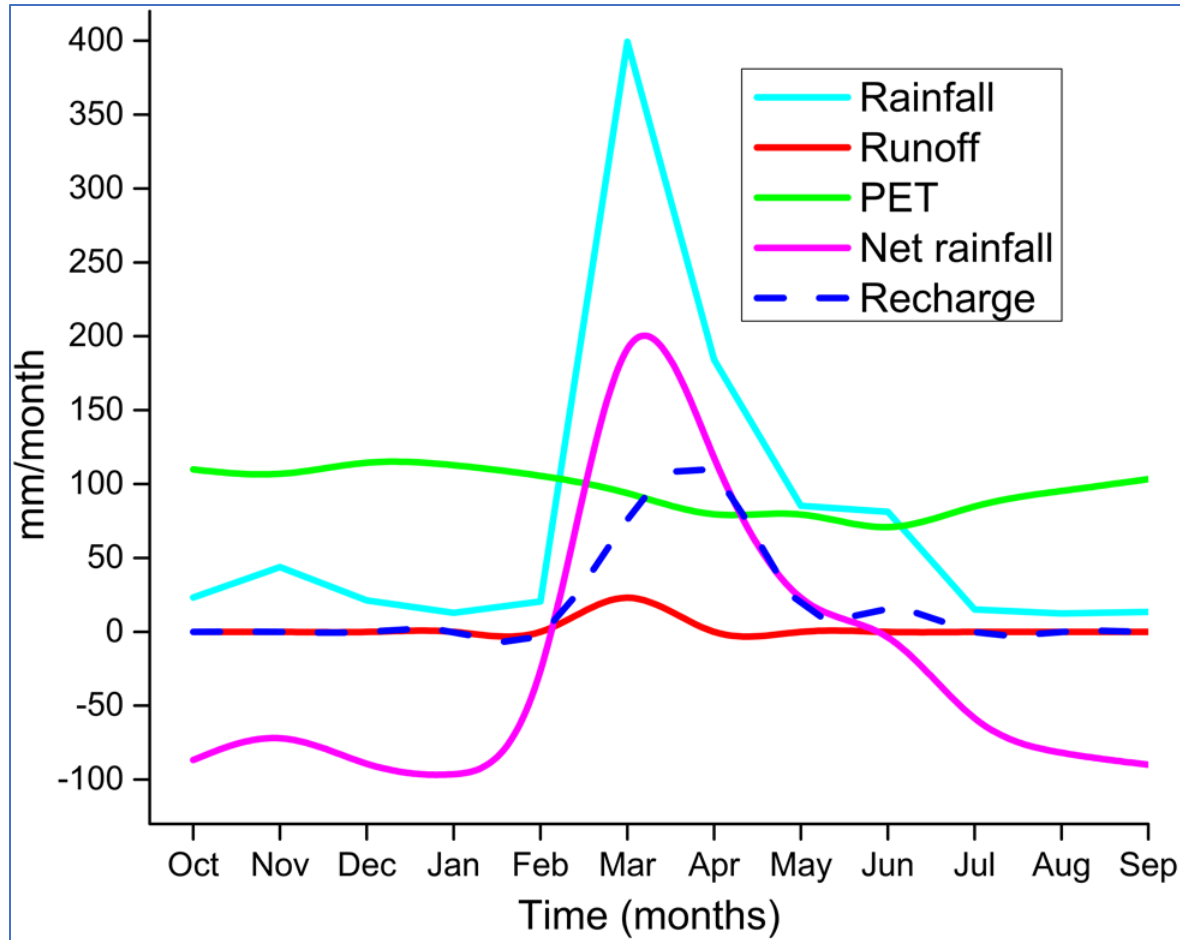
Figure 5. A 1996/1997 hydrological year graph of rainfall, runoff, PET, net rainfall, and aridity index in the Kimbiji aquifer.